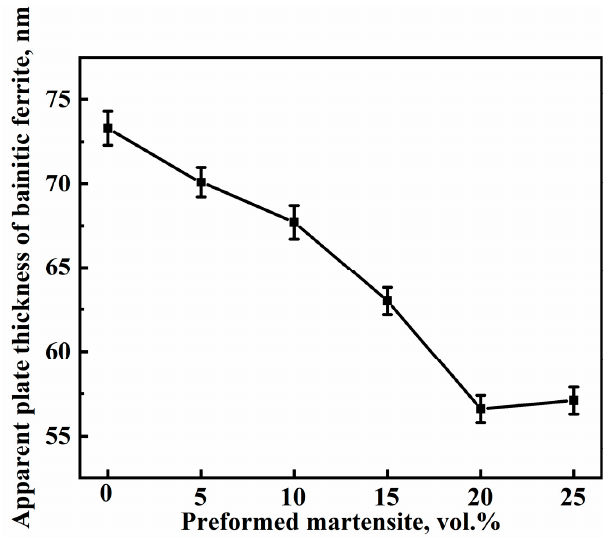
Figure 4. Apparent plate thickness of bainitic ferrite of specimens with different treatment processes. Note: For each specimen, about 400 measurements were conducted on multiple TEM images to obtain statistically representative results